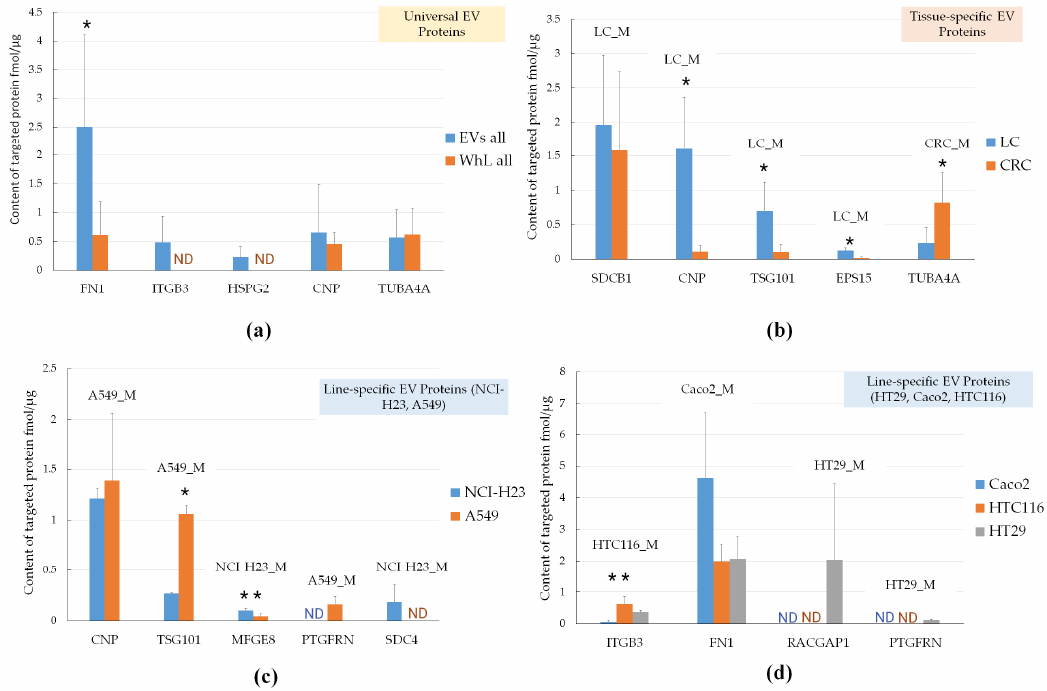
Figure 7. Selected reaction monitoring analysis (SRM) with the stable isotope-labeled peptides standards (SIS) analysis of EV proteins: ( a ) universal, ( b ) tissue-specific (LC_M and CRC_M), and ( c ) LC-line specific markers (NCI-H23_M, A549_M), and ( d ) CRC-line specific markers (HTC116_M, Caco2_M, and HT29_M). * p -value < 0.01; ** p -value < 0.05; Error bars represent standard deviation for measurements performed at 15, 9, 6, and 3 points for universal, lung tissue-specific, colon tissue-specific, and line-specific markers, respectively. For each cell line, EV isolation was performed in three biological replicates and yielded three EV sample. Each sample was analyzed using SRM with SIS in three technical replicates with coefficient of variation below 20%. ND—not detected.